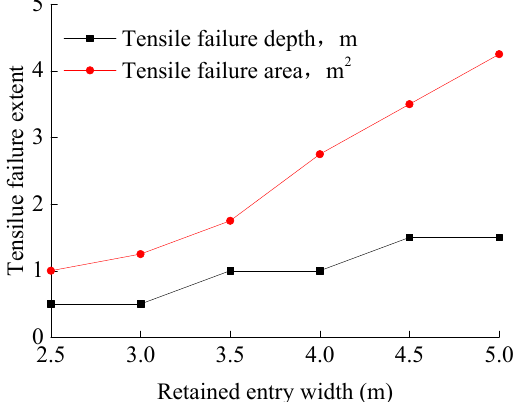
Figure 10. Effect of retained entry width on roof failure.